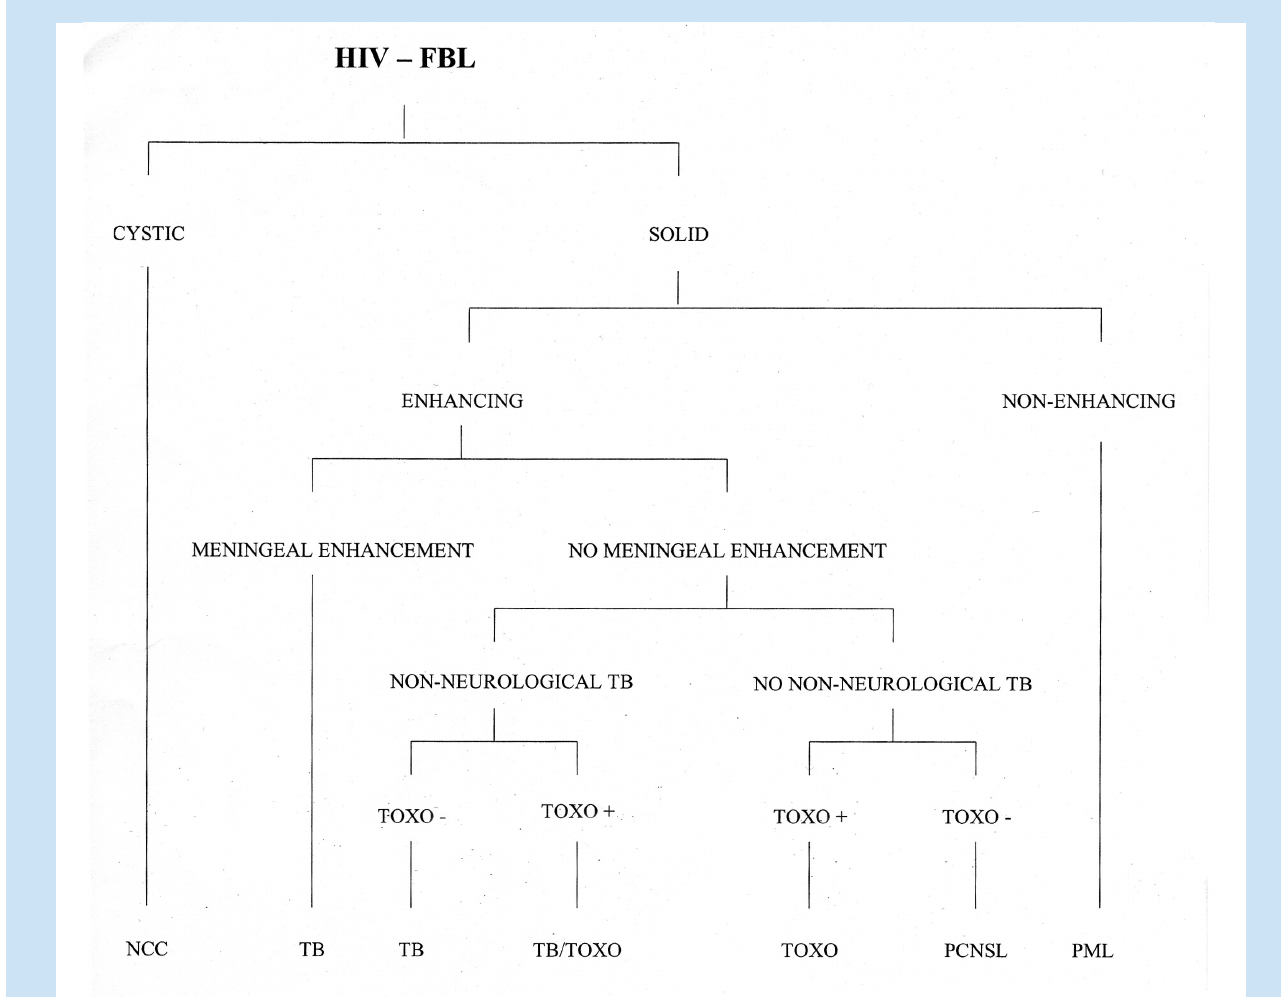
Fig.3. Algorithm for the initial assessment of HIV-associated focal brain lesions (FBLs) in developing regions.( TB =tuberculosis, NCC = neurocysticer- cosis, TOXO = toxoplasmosis, PCNSL= primary central nervous system lymphoma, PML= progressive multifocal leucoencephalopathy, + = positive, - =